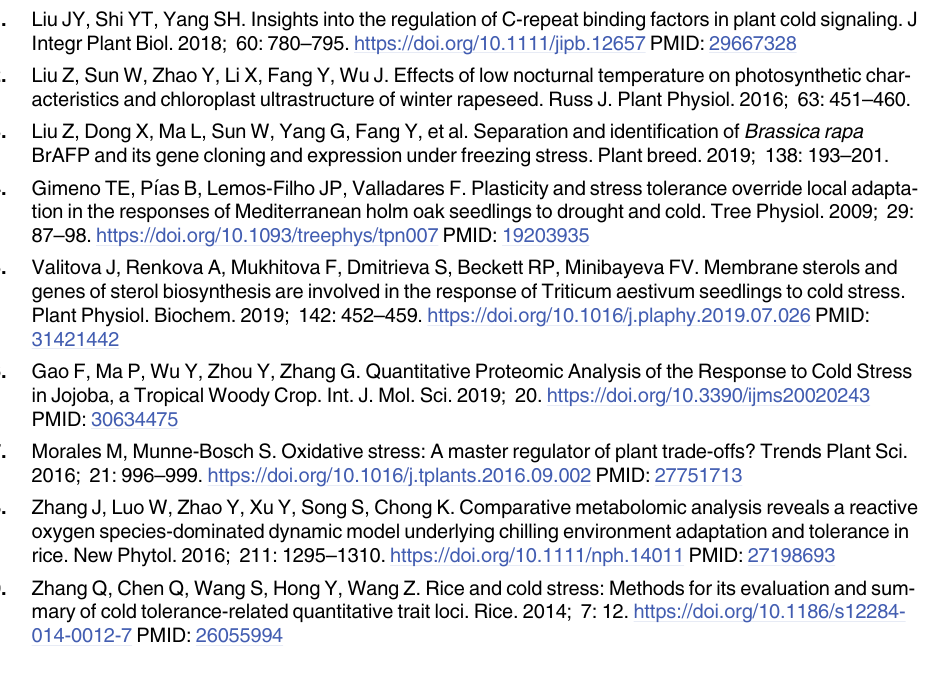
S3 Table. Gene ontology (GO) analysis of differentially expressed cold-related genes of NS and NF. S4 Table. Candidate pathways and candidate proteins information. S5 Table. Primer of qRT-PCR. S6 Table. Candidate proteins